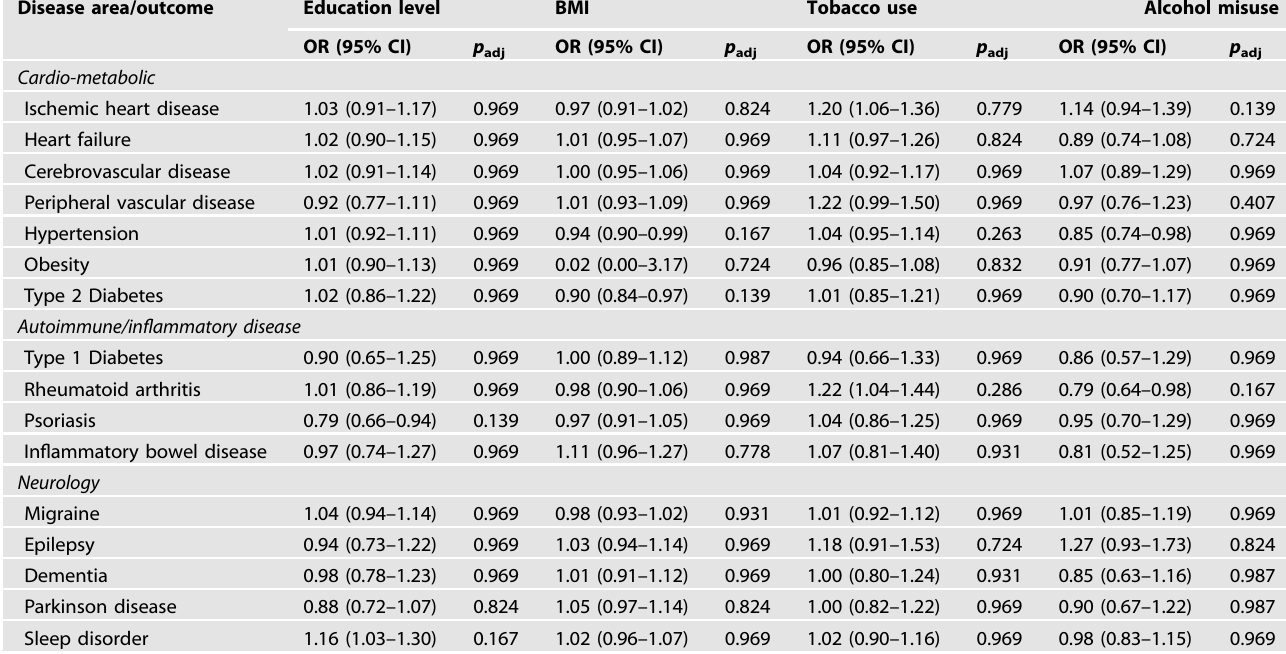
Table 3. Moderation of ADHD-PRS associations with somatic health outcomes by education, BMI, tobacco use, and alcohol misuse. Disease